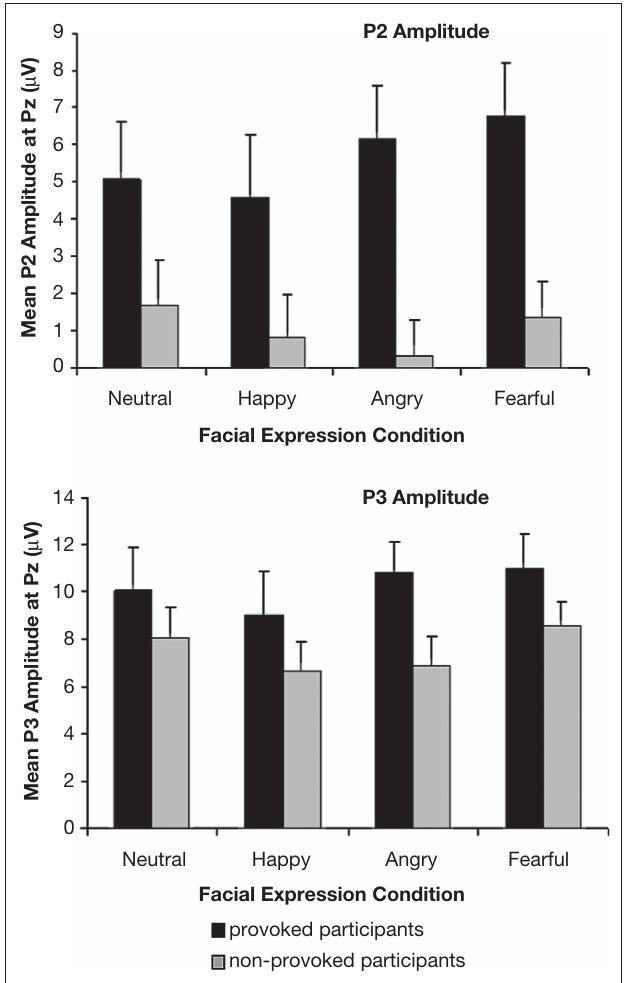
FIGURE 4 | Mean P2 and P3 amplitudes (µV) for the provoked and non-provoked participants at Pz electrode site separately for the neutral, happy, angry, and fearful